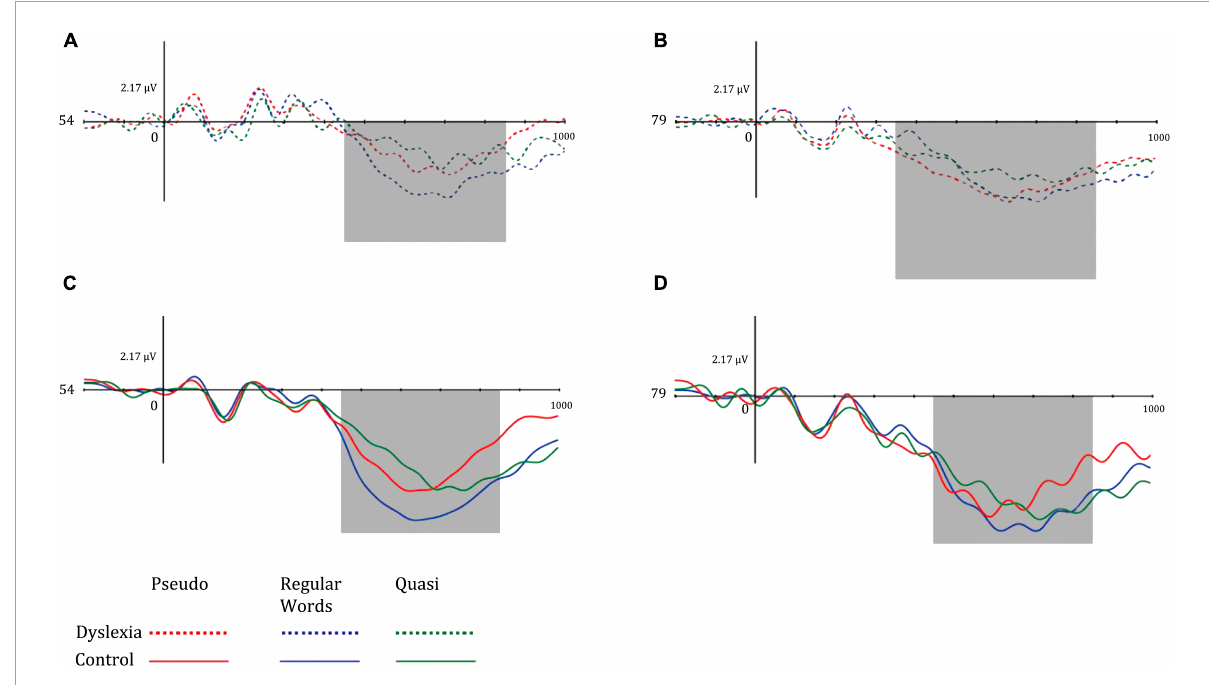
FIGURE6 Mean amplitude of the left mid-parietal P600 component for (A) dyslexia group and left hemisphere, (B) dyslexia group and right hemisphere, (C) control group and left hemisphere, and (D) control group and right hemisphere. Dotted lines represent the dyslexia group, while solid lines represent the control group. Red-colored lines represent pseudo words, blue-colored lines represent regular words, and green-colored lines represent Quasi words.